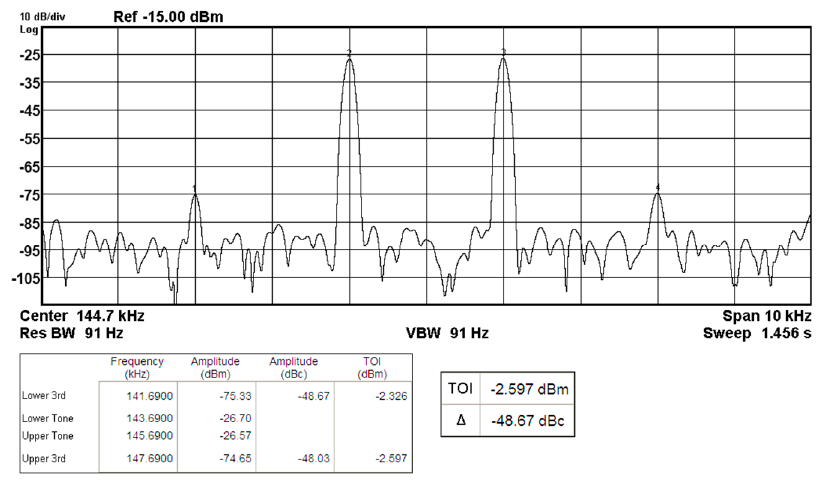
Figure 22. Third-order intercept (TOI) measurement of BP filter.